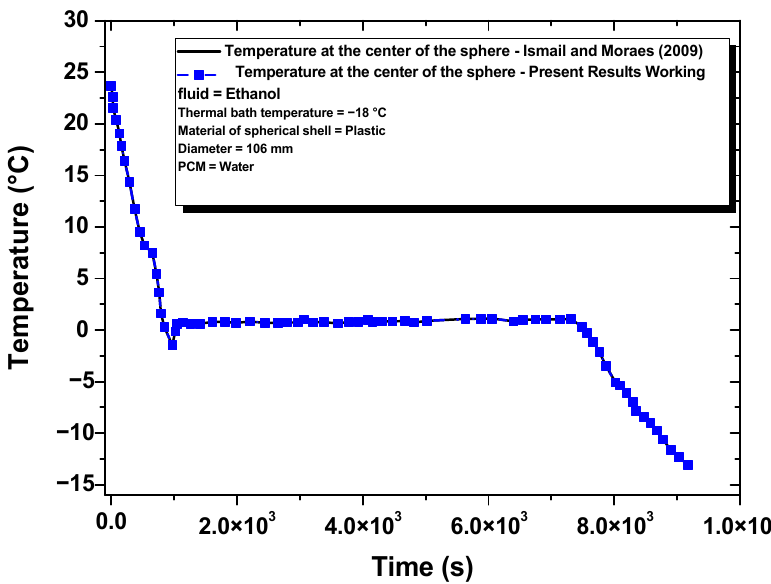
Figure 7. Comparison of the predicted temperature with the experimental data from [10].